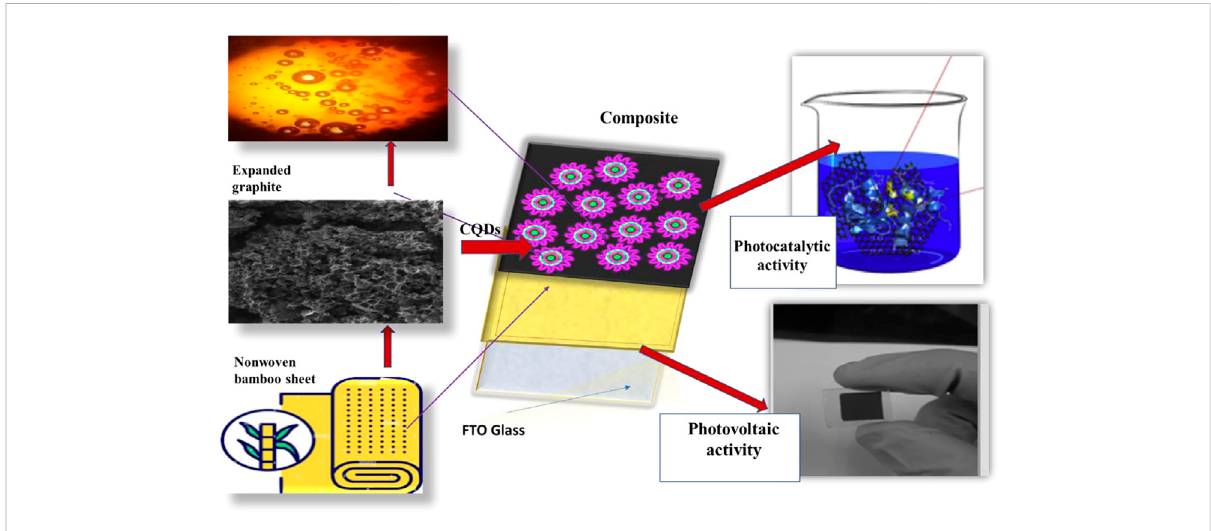
FIGURE 1 Schematic illustration of composite to experimental